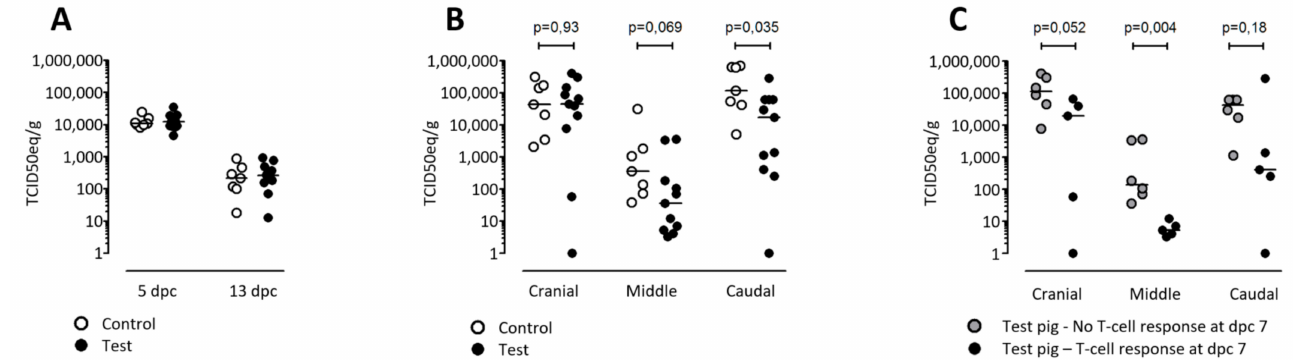
Figure 7. Virus load in serum and lung tissue analyzed by qRT-PCR. ( A ): Virus load in the serum at dpc 5 and 13 given in TCID 50 equivalents per ml serum. ( B ): Virus load in the lung tissue from cranial, middle, and caudal parts of the lung prepared from cutouts of 0.2–0.4 g and normalized to TCID 50 equivalents per 1 g of tissue. ( C ): Virus load in lung tissue from test pigs only, displayed as non-T-cell-responders versus T-cell-responders at dpc 7, differentiated using the ratio-2 method. All P-values were calculated using Mann–Whitney. All measurements were performed in duplicates and were converted from cq-values using a standard curve based on a purified 10-fold dilution series of the challenge isolate. Group medians are indicated with a line. Virus load in the lung tissue from cranial, middle and caudal parts of the lung were prepared from cutouts of 0.2–0.4 g and normalized to TCID 50 equivalents to 1 g of